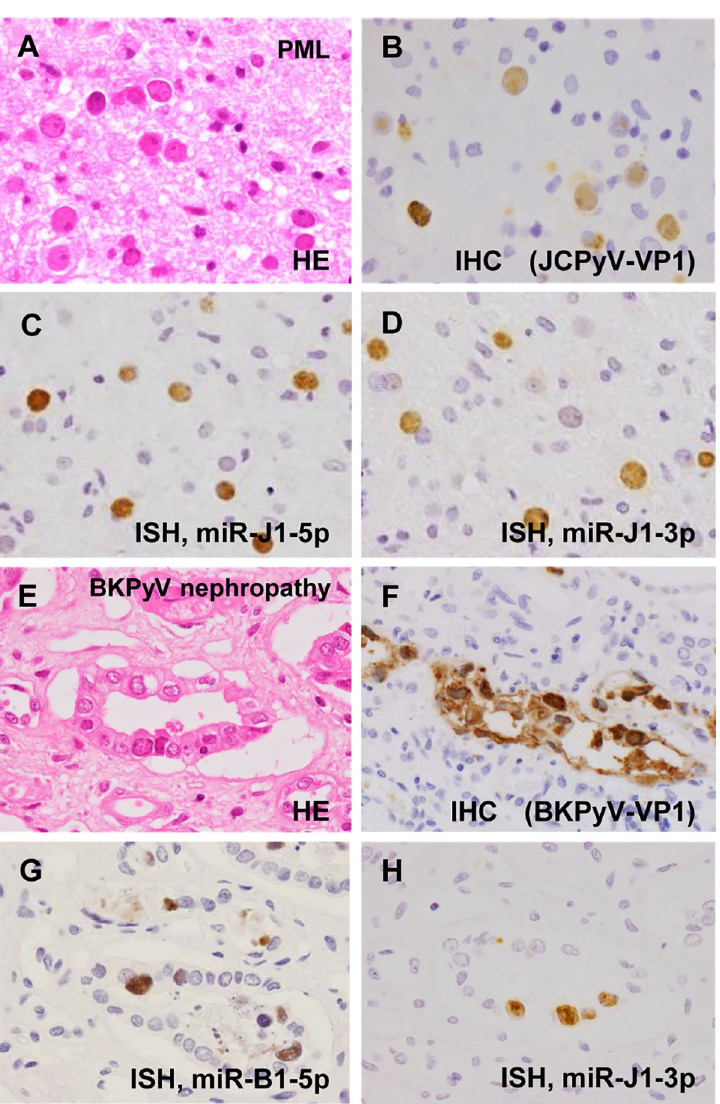
Fig 1. In situ hybridization (ISH) for miR-J1 and miR-B1 in clinical samples. (A–D) PML. (A) Haematoxylin and eosin (HE) and (B) immunohistochemistry for JCPyV VP1, (C) ISH for miR-J1-5p, and (D) ISH for miR-J1-3p.